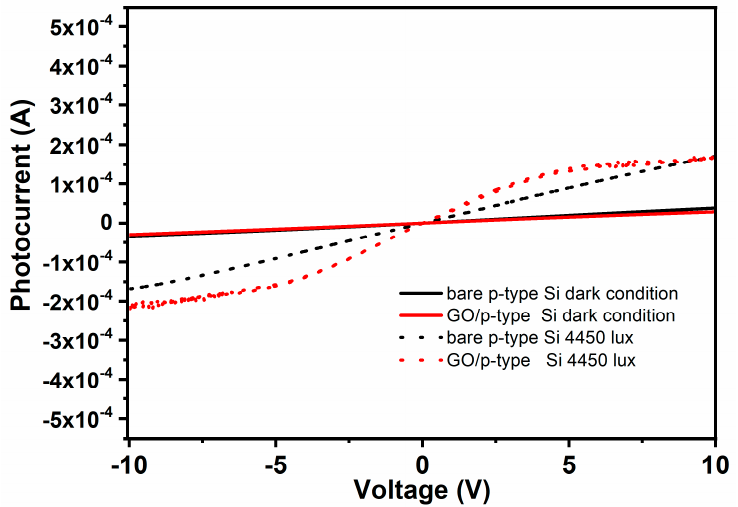
Figure 6. Cyclic voltammetry measurements on p-type silicon and graphene oxide/p-type Si samples under dark and light illumination conditions.